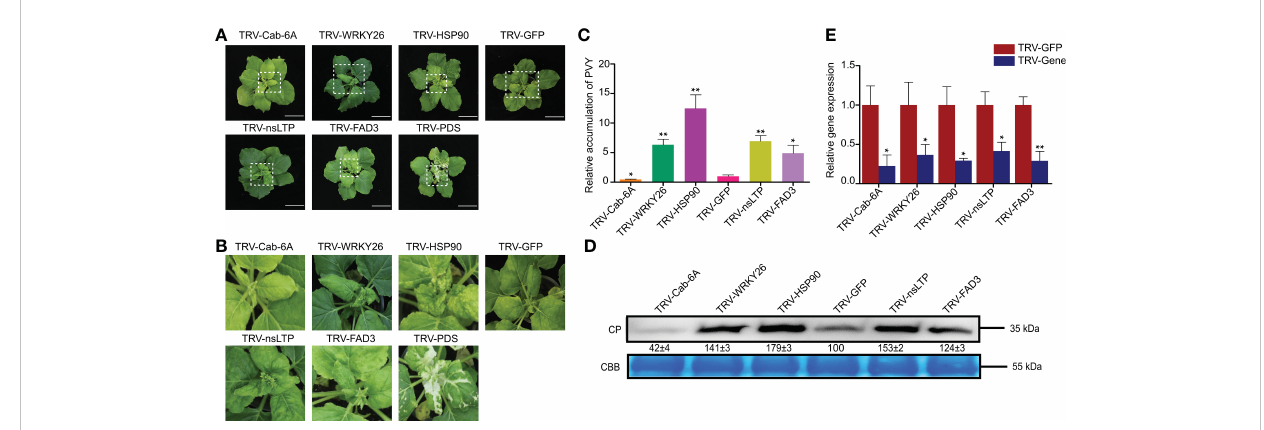
FIGURE 9 Functional analyses of fi ve homologous genes in resistance to PVY infection through TRV-based VIGS assays in N. benthamiana . (A) Disease symptoms on different gene-silenced N. benthamiana plants after PVY infection. (B) Close-up views of upper leaves indicated by white dash boxes in (A) . (C) The accumulations of PVY genomic RNAs determined by RT-qPCR in different gene-silenced N. benthamiana . Asterisks indicate statistical difference between treatments, determined by the two-tailed t test (*, P < 0.05; **, P < 0.01). (D) The expression levels of PVY CP proteins in upper leaves of N. benthamiana . CP, coat protein; CBB, Coomassie brilliant blue. (E) Silencing ef fi ciencies of target genes determined through RT-qPCR. Asterisks indicate statistical difference between treatments, determined by the two-tailed t test (*, P < 0.05; **, P <